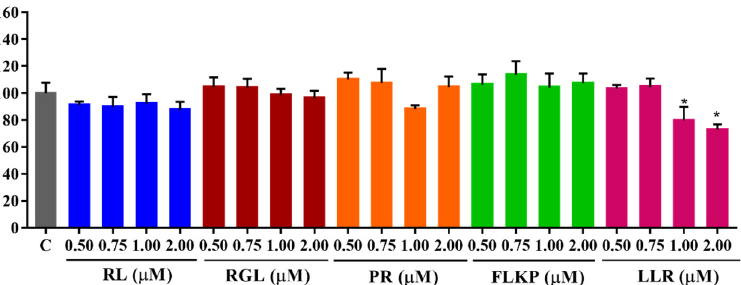
Figure 10. Cell viabilities of HepG2 cells treated with synthetic peptides. “C” represents the control group. Data were expressed as mean ± SD ( n ≥ 3, p < 0.05). “*” indicated a significant difference from the control group ( p < 0.05).